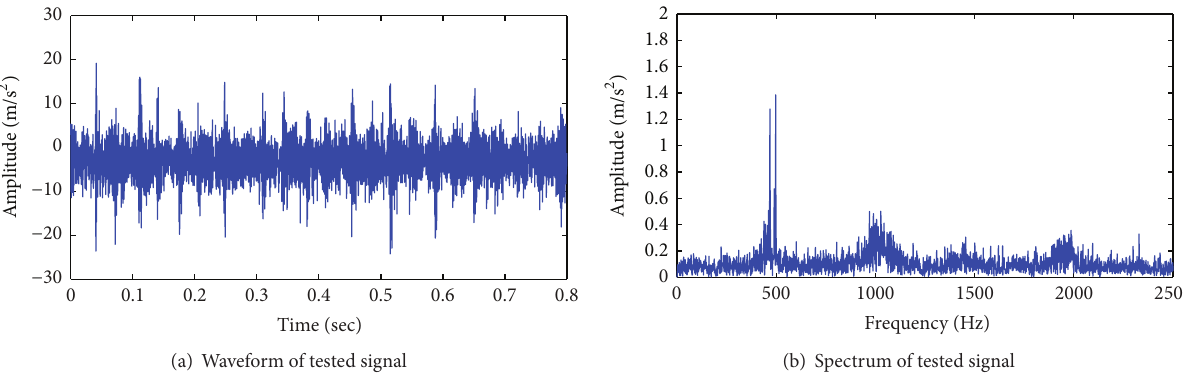
Figure 11: Waveform and spectrum of tested signal.